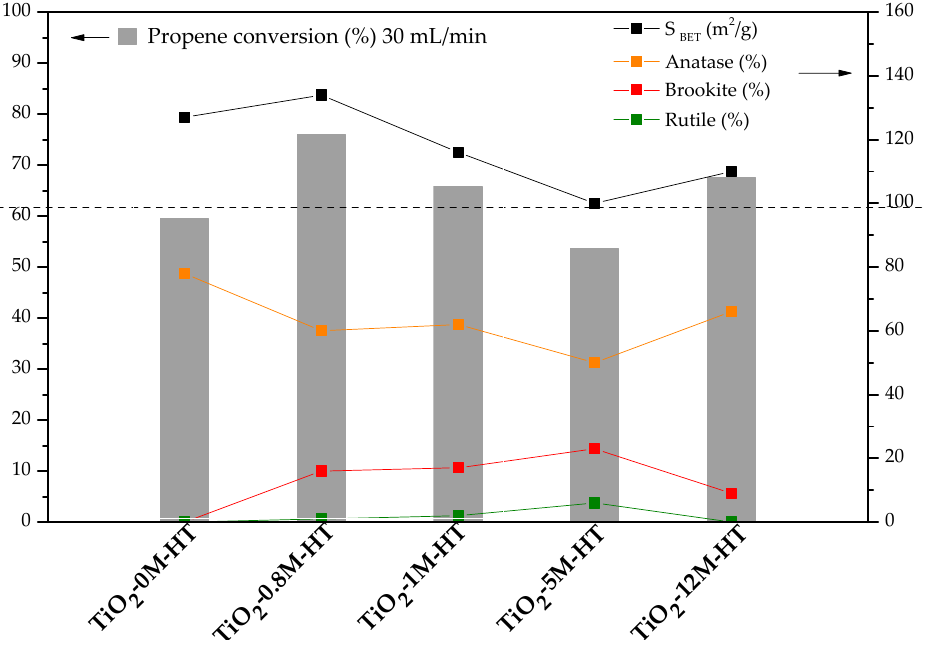
Figure 8. Propene conversions (30 mL/min), surface areas and weight compositions of crystalline phases for the HT-materials.